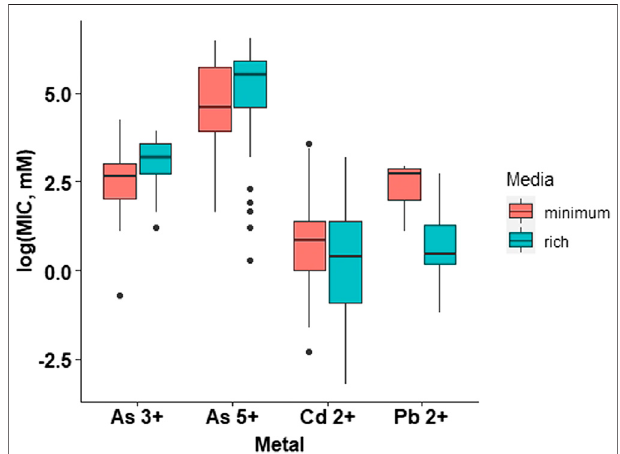
FIGURE 3 | Bacterial metal tolerance in terms of the logarithm of the Minimum Inhibitory Concentration (MIC), as a function of the type of media (Minimum and Rich) and the type of metal (As 3+ . As 5+ . Cd 2+ , Pb 2+ ) analyzed with a two way ANOVA in RStudio 3.5.1. We present an analysis of 655 MICvaluesobtainedfromdifferentresearcharticlesofdifferentstrains/species of bacteria associated with the plant